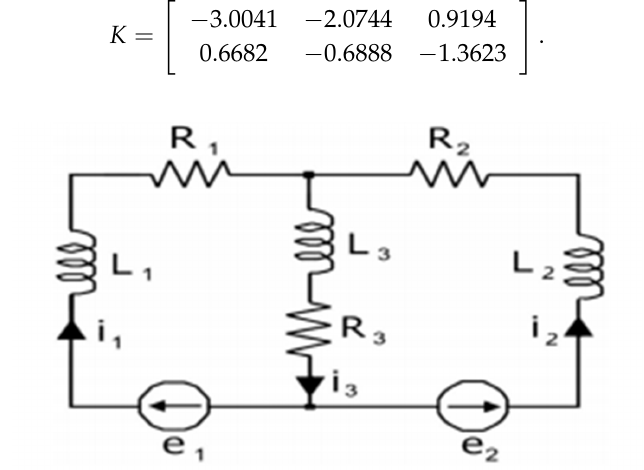
Figure 1. Electronic